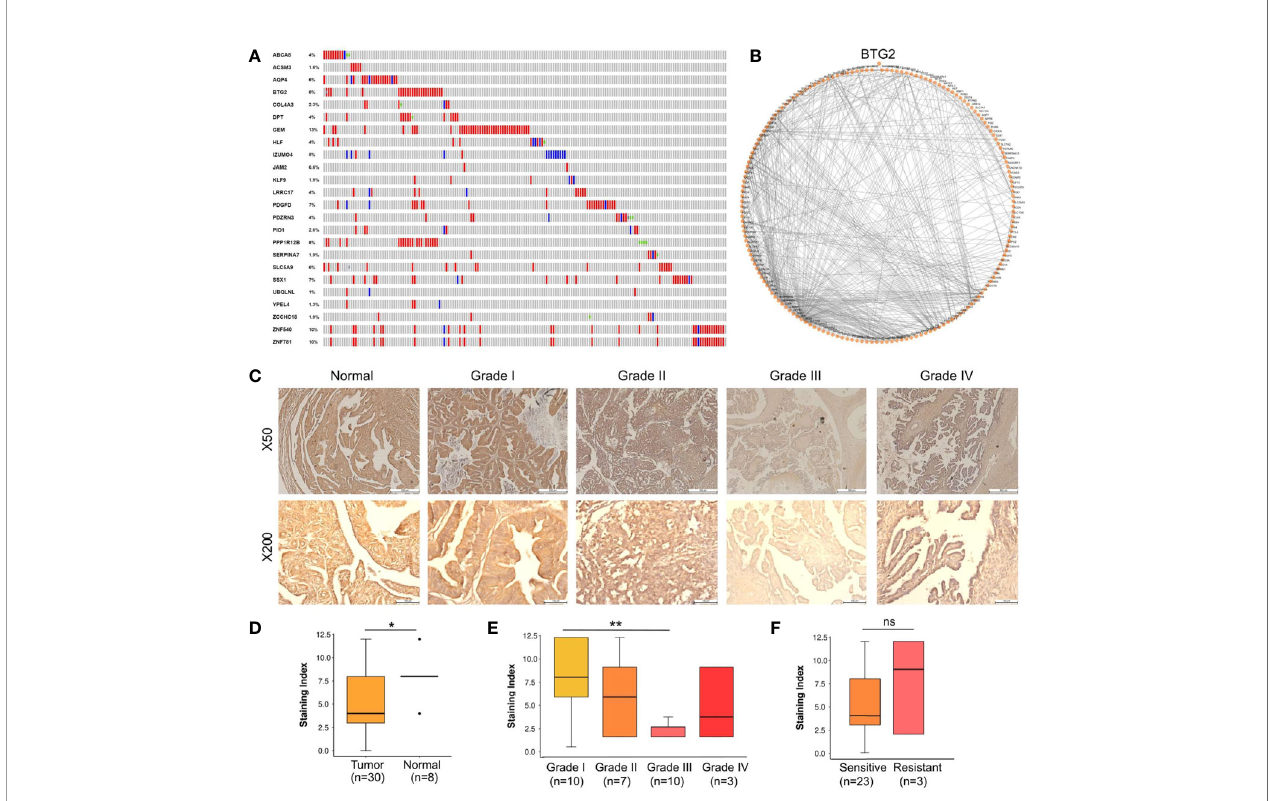
FIGURE 3 | BTG2 as a potential tumor suppressor candidate in ovarian cancer. (A) Gene mutations and copy-number alterations analysis of 24 genes were analyzed using cBioPortal. Tumor samples are shown in columns. (B) Diagram of the individual modules and their interactions of BTG2 module. Circles (nodes) represent the 128 modules, with the circle size proportional to module size. Edges connect modules that share PPIs. (C) Normal samples showed normal fallopian tube epithelium tissues and Stage I-IV samples showed ovarian cancer tissues. (D) BTG2 staining index was lower in ovarian cancer tissues compared to normal tissues in ovarian cancer patients. (E) BTG2 staining index of ovarian cancer tissues was relative to tumor grade. (F) Correlation between sensitive and resistant expression of ovarian cancer was analyze. *p < 0.05, **p < 0.01, ns is